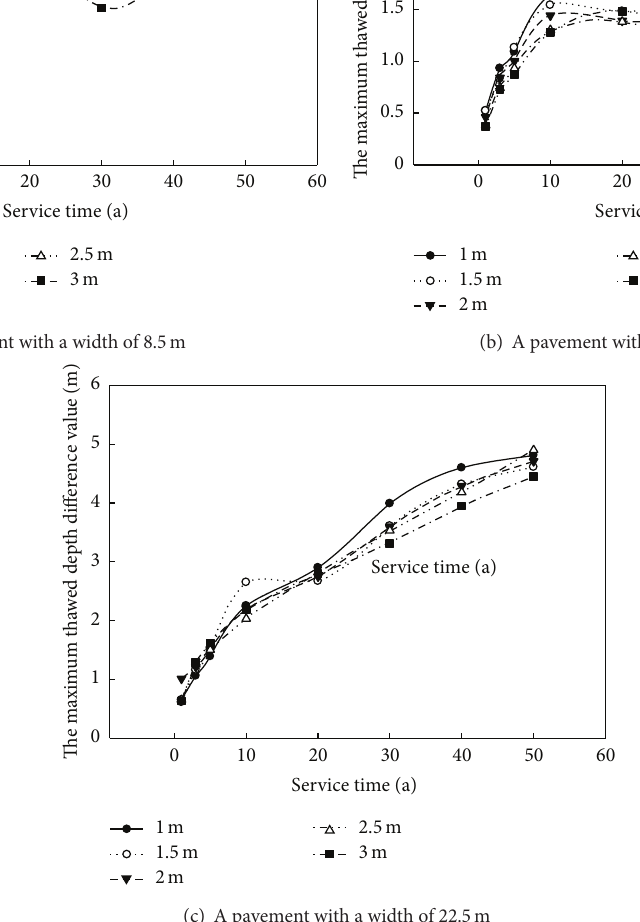
Figure 7: The maximum thawed depth difference value under concrete pavements and asphalt pavements versus service time curve under different pavement